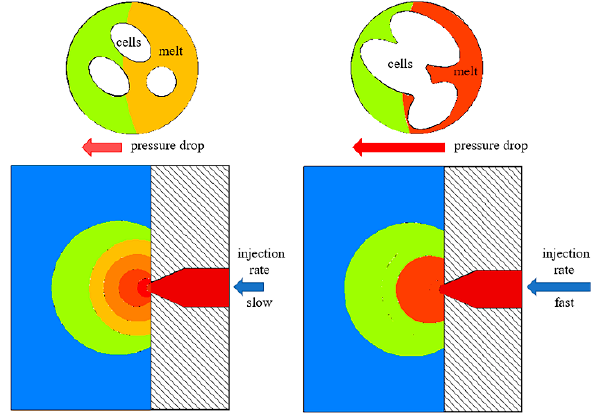
Figure 3. Schematic diagram of the correlation between the initial injection rate and the cell structure in the melt front.